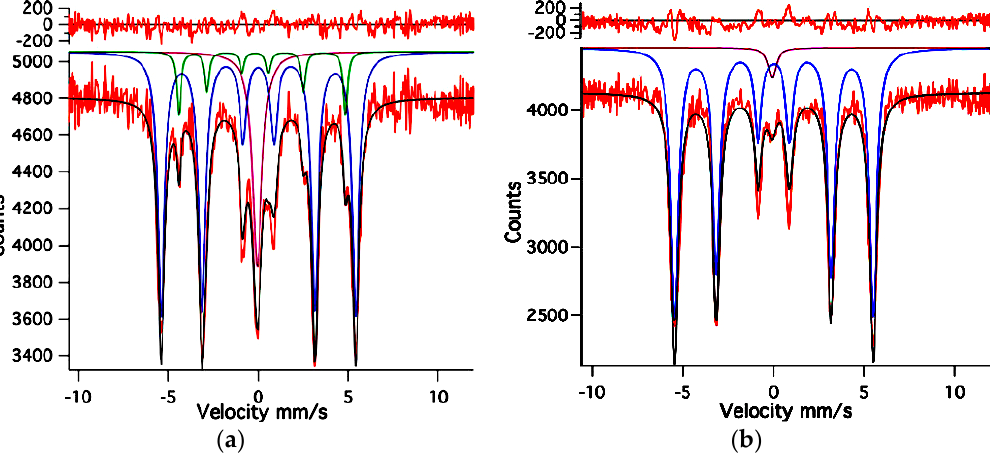
Figure 35. Room temperature synchrotron Mössbauer spectra of the Tazewell IAB-sLH iron meteorite selected areas: cloudy zone ( a ) and plessite area ( b ). Indicated spectral components are the results of the fits. The differential spectra are shown on the top. Adapted from [43].